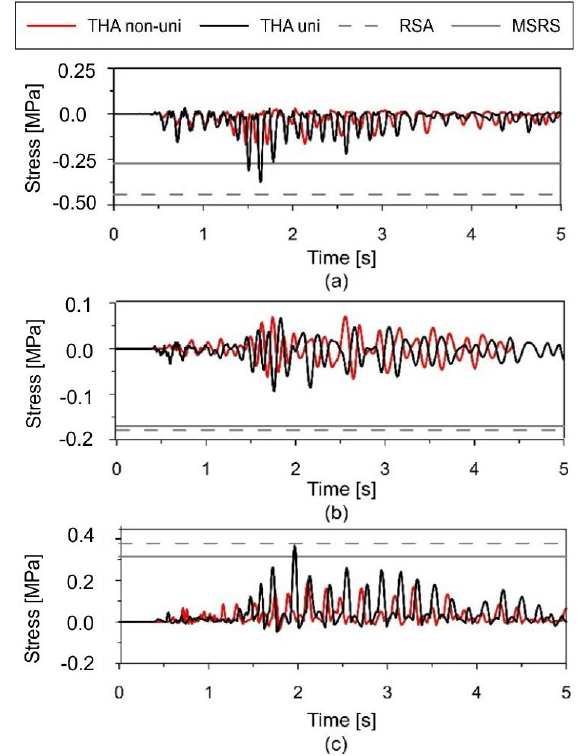
Figure 18. Comparison of extremal principal stresses obtained from di ff erent calculation methods for the mining-induced shock in the LGCD region at the span zone elements: ( a ) W1; ( b ) W2; ( c )